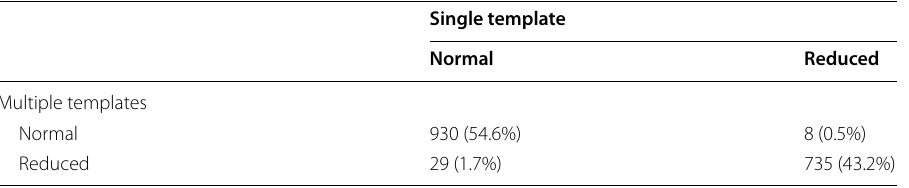
The cutoffs derived from the fits of the two Gaussian functions were used for binary classification (0.995/0.904 for single/ multiple templates)